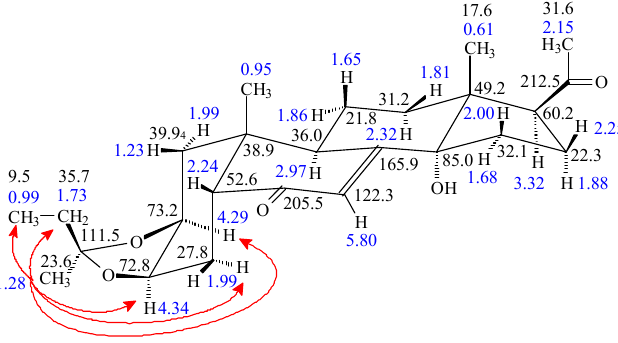
Figure 2. Stereostructure and one-dimensional selective Rotating frame Overhauser Enhancement Spectroscopy (ROESY) responses (irradiated at R 2 : δ = 1.28 ppm) of compound 8 . Blue numbers refer to 1 H chemical shifts; black numbers give the 13 C δ values.